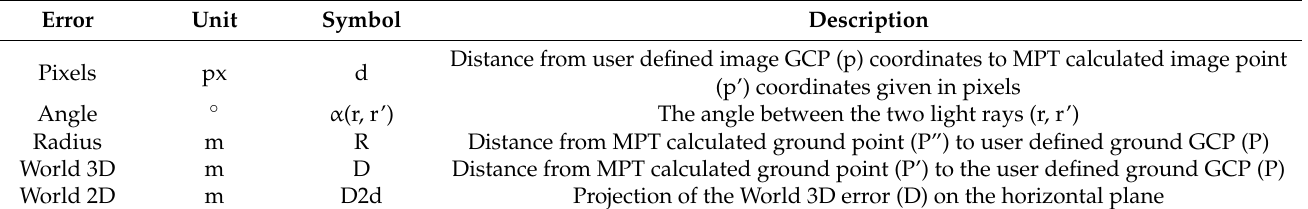
Table 1. Summary of MPT camera calibration errors as shown in the software.